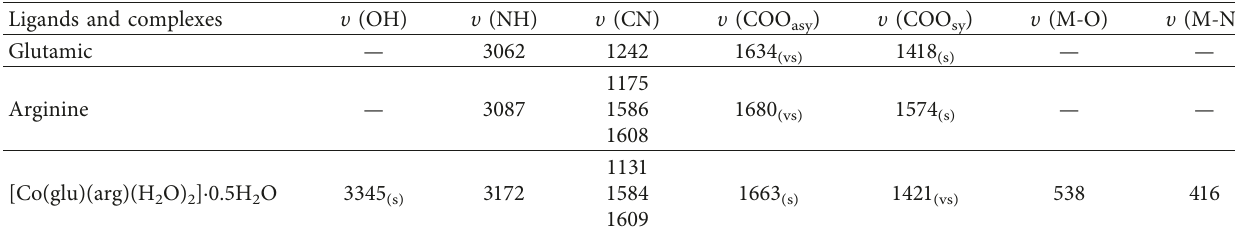
Figure 2: Optimized geometry around the central transition metal ions showing different bond lengths and angle. Table 2: Experimentally and theoretically simulated IR spectra (in cm − 1 ) of the studied complexes. Assignment of experimentally measured IR key modes.